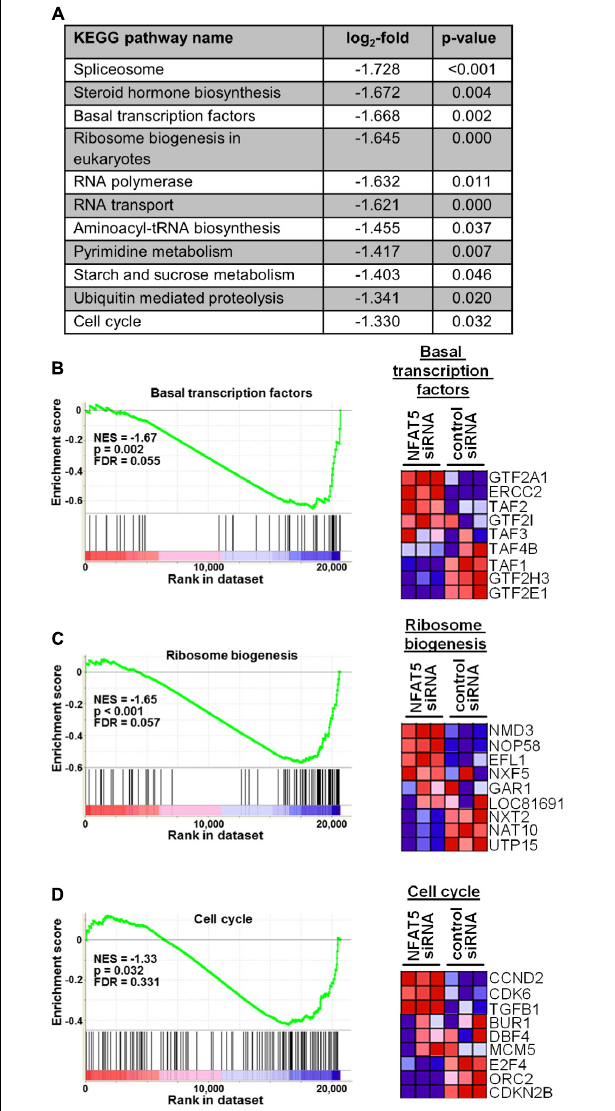
FIGURE 7 | Gene set enrichment analyses (GSEA) based on the KEGG pathway database. HUASMCs from three donors were treated with NFAT5-specific or control siRNA and exposed to biomechanical stretch for 24 h. RNA was isolated and processed for genome array analysis (HuGene-1 0-st-v1 array, Affymetrix). The table (A) lists all significantly DOWN-regulated gene sets associated with the indicated pathways/functions (log2-fold regulation, p < 0.05 NFAT5 knockdown vs. control, n = 3, one-way ANOVA; access# for full microarray data via Gene Expression Omnibus (GEO): GSE106274). Exemplary results of the subsequent gene set enrichment analyses (GSEA) for selected gene sets (enrichment plots) and the corresponding statistical values are shown [ B–D ; NES: normalized enrichment score; p: p -value (ANOVA); FDR: false discovery rate]. Additionally, the heat map corresponding to the enrichment plot for cell cycle-associated genes is shown.